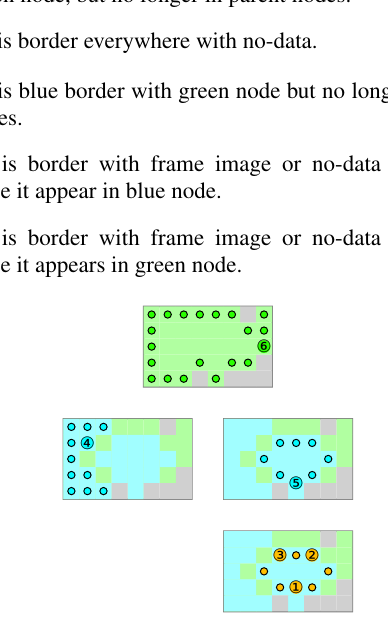
Figure 5. Pixel borders with C4